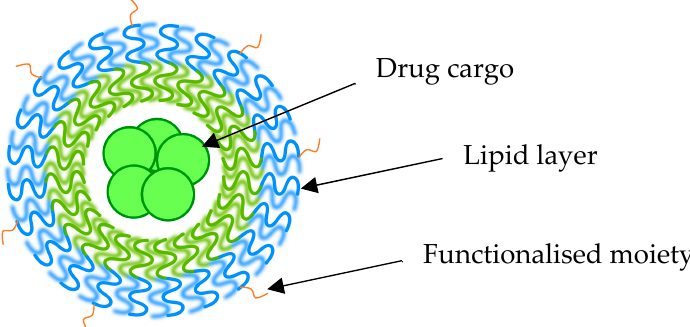
Figure 2. Schematic representation of a functionalised nanoparticle loaded with drug.